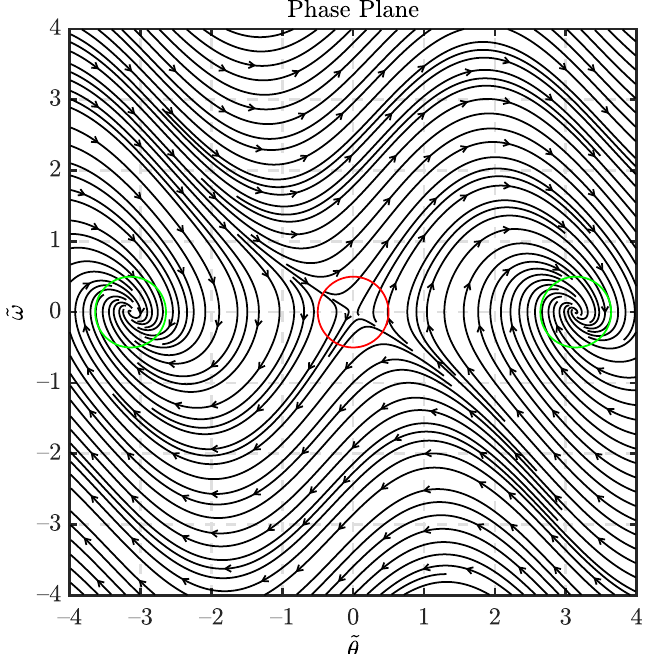
Figure 6. Traditional PLL reversed phase